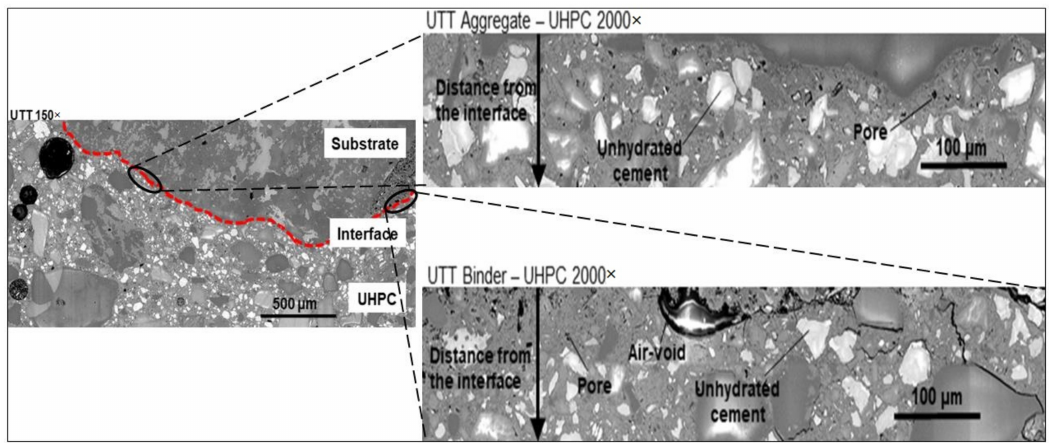
Figure 14. Interfacial bond zone of composite specimen using untreated plywood at 150 × and 2000 × .